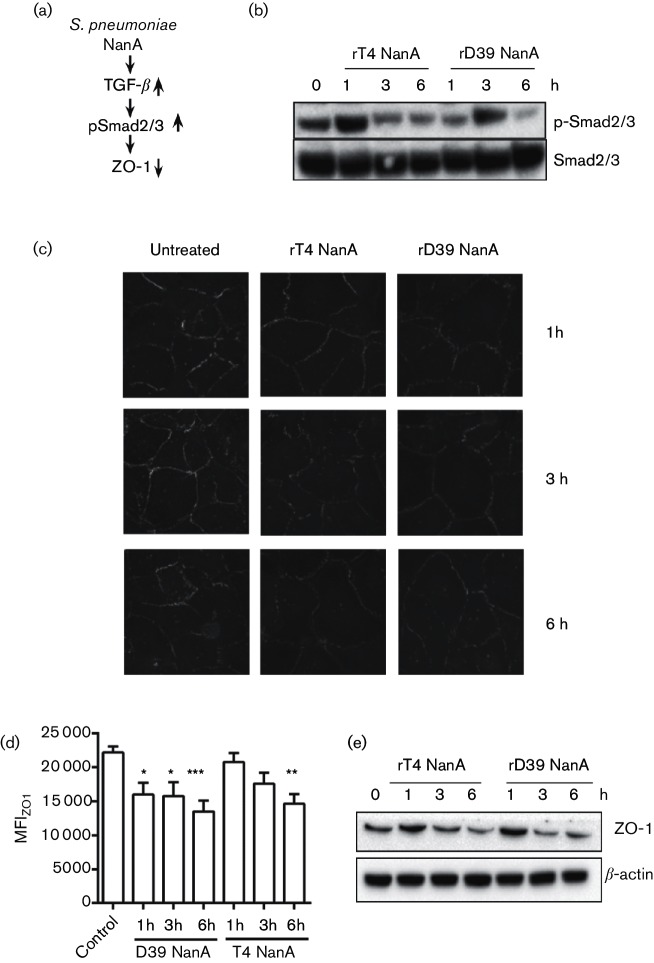
Activity of recombinant NanA on host barrier cells. (a) Scheme of the proposed signalling pathway linking NanA-mediated activation of TGF-β to decreased expression of tight junction proteins. (b) Western blot showing phosphorylation of SMAD2 and SMAD3 proteins after stimulation with recombinant TIGR4 and D39 NanA for 1, 3, 6 h in hBMECs. Equal loading was confirmed using total SMAD2/3. Representative of three independent experiments. (c) Confocal imaging showing expression of ZO-1 in endothelial hBMECs after treatment with recombinant full-length (D39) or truncated (TIGR4) NanA for 1, 3 and 6 h. Representative images from three independent experiments. Magnification: ×63. (d) Quantitation of panel A. *P<0.05, **P<0.01, ***P<0.001. (e) Western blot showing tight junction protein ZO-1 in hBMECs after stimulation with recombinant TIGR4 or D39 NanA proteins (1 µg ml−1) for indicated time points. β-actin served as a loading control. Representative of three independent experiments.